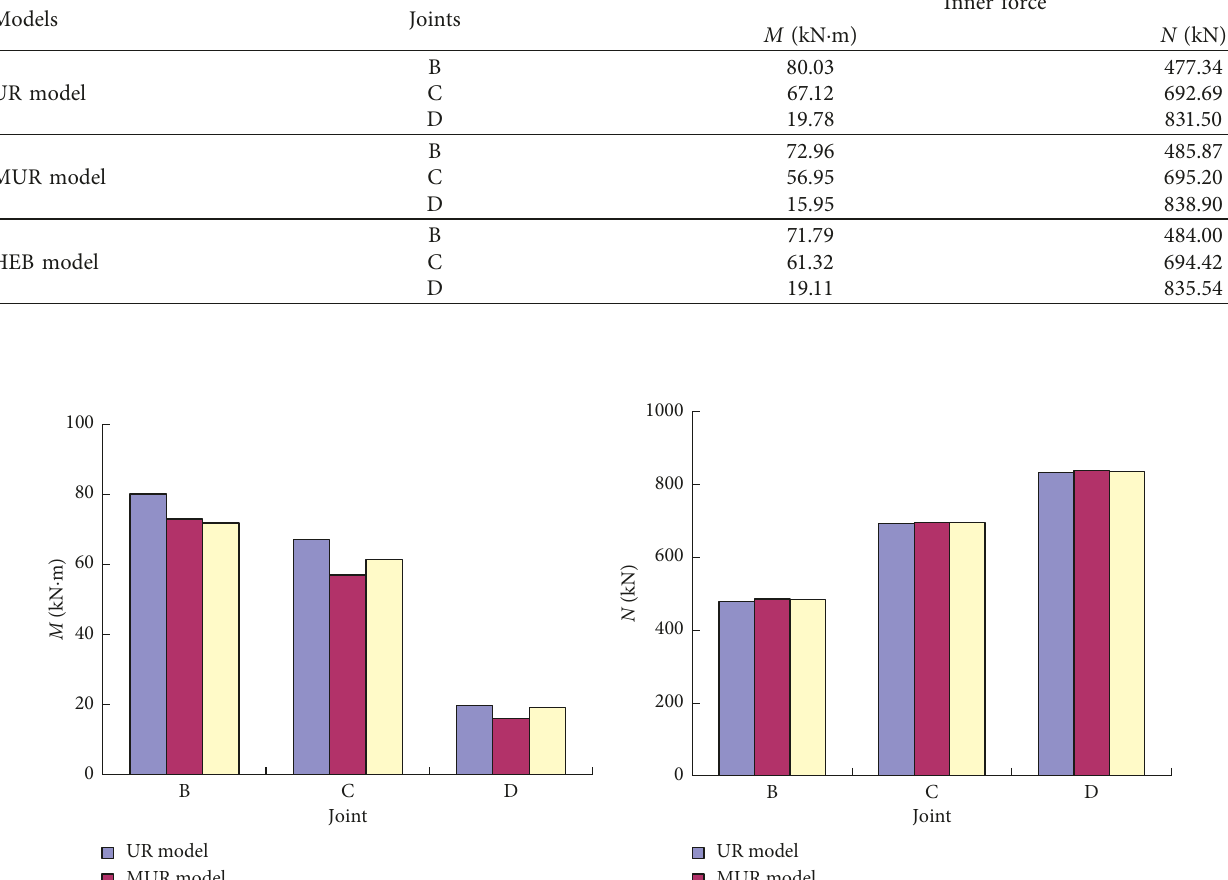
Table 6: Final calculation results of inner force on joint sections calculated by the 3 models. Models Joints